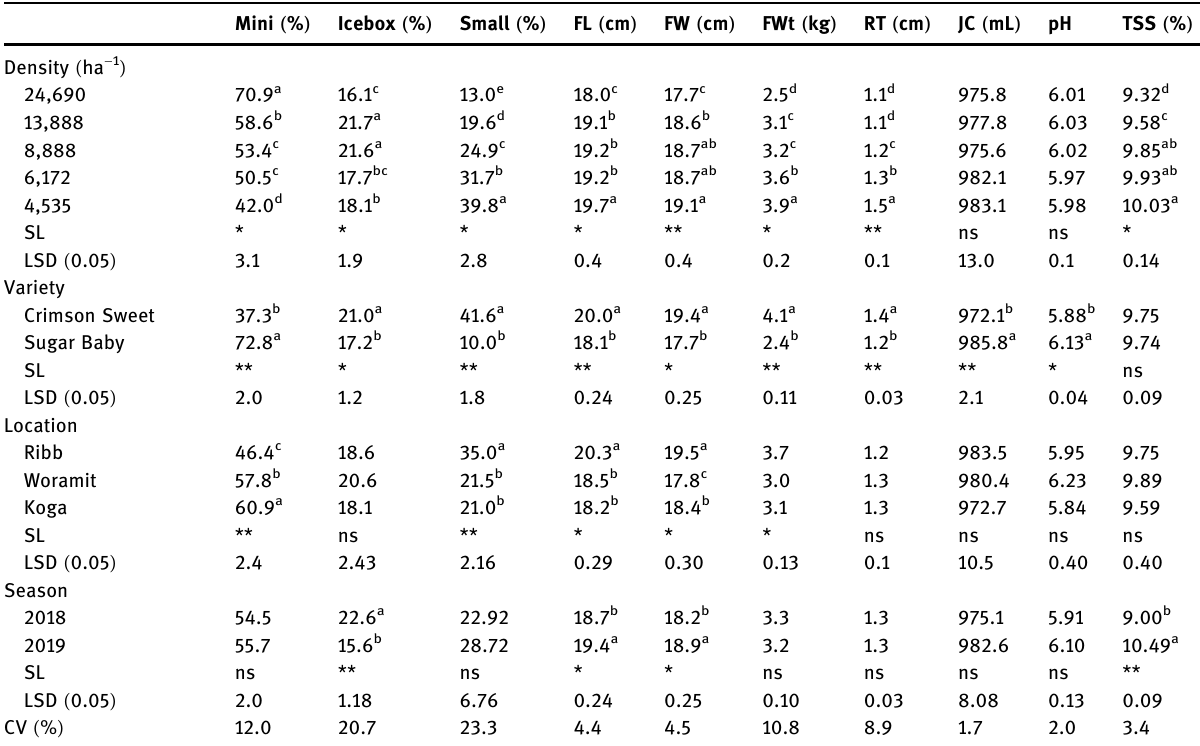
Table 4: Main e ff ects of density, variety, location, and season on fruit size category and quality attributes of watermelon Mini ( %